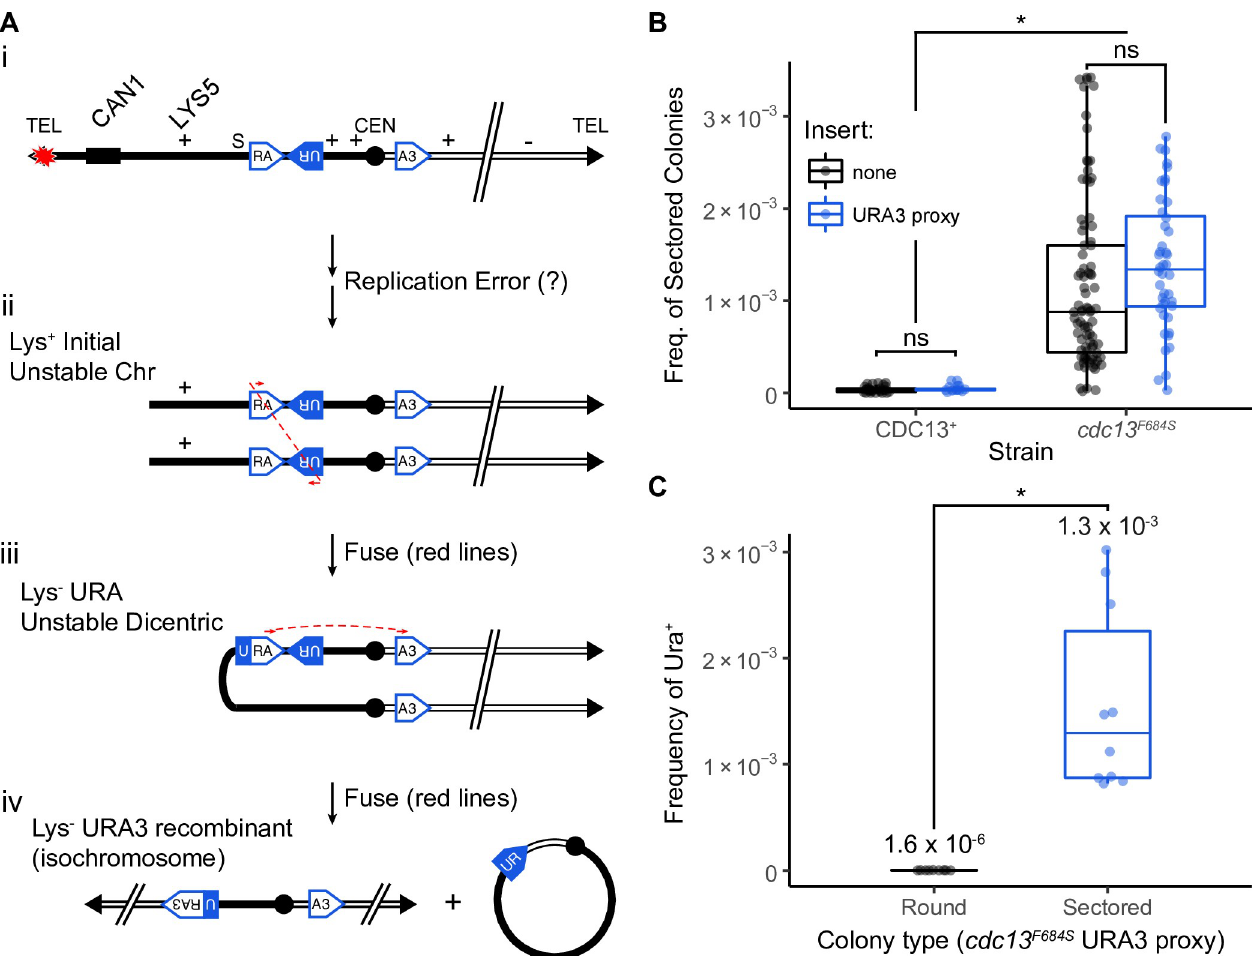
Fig 5. cdc13 F684S -induced unstable chromosomes progress to centromere-proximal dicentric at a semi-restrictive temperature (30˚C). (A) Model for the URA3 proxy translocation. Two modules, RA and RU are inserted into the left arm as inverted repeats, and the third module (A3) is inserted into the right arm (i). An inverted fusion between UR and RA forms a dicentric chromosome (ii). A secondary event, a direct repeat fusion between URA and A3, (iii) removes a centromere and (iv) creates a functional URA3 gene. (B) Frequency of sectored colonies between strains with (blue) and without (black) the URA3 proxy system is unchanged. Fold change and statistical significance relative from the corresponding Wild Type frequency are noted ( � < 0.01; Mann-Whitney U). (C) Frequency of URA3 + cells in round (black) and sectored colonies (blue) in cdc13 F684S . The statistical significance between round and sectored colonies is depicted ( � < 0.01; Mann-Whitney